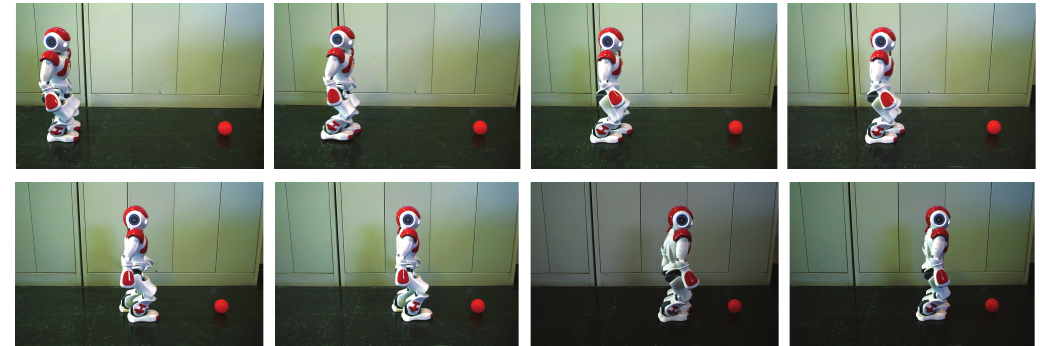
Figure 11: Results relative to an intentional object tracking: the robot tracks a red ball moving toward